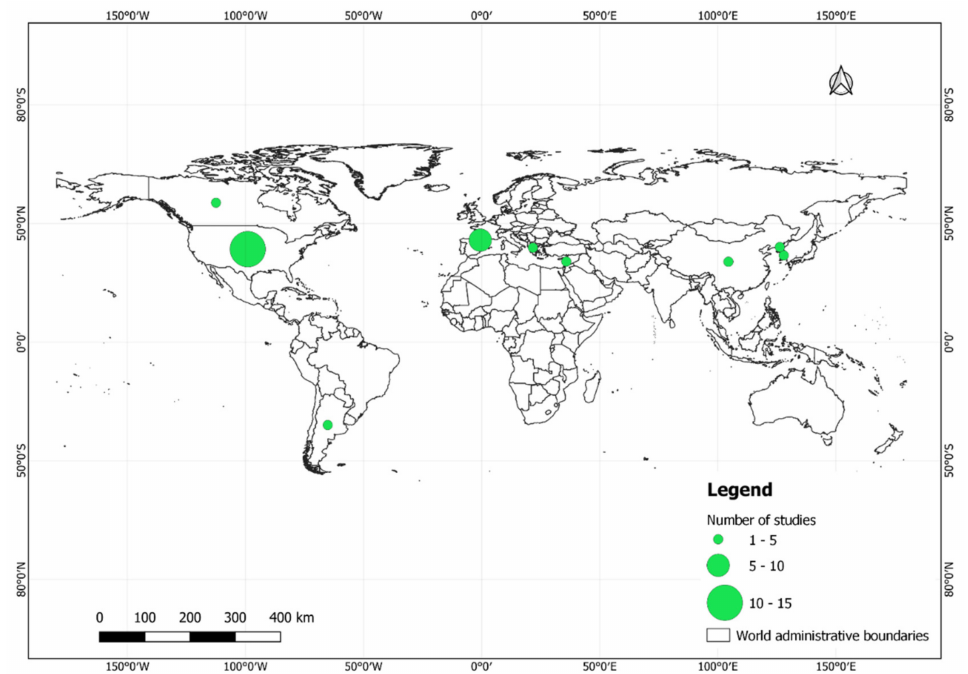
Figure 2. Map of the world showing the geographical distribution of the selected studies.